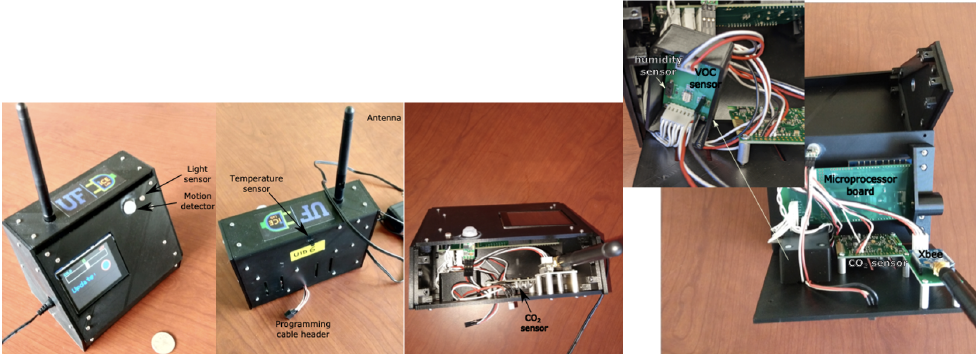
Figure 4. A production version of a PCFN with the internals exposed. The slots on the back cover and the gap on the front cover ensure adequate airflow through the case for the VOC and humidity